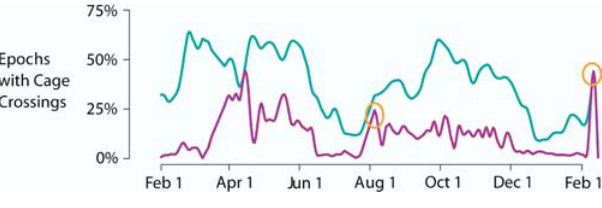
Figure 1. Activity Across the Year The purple line traces the (smoothed) percentage of 30-s epochs at night during which a bird (no. 38) broke an infrared beam by crossing the cage. The blue line shows the same information for the hours of light. Note the broad peak in activity between March and June and the broader and lower peak in activity between August and December, corresponding to the spring and fall migrations, respec- tively. The low levels of activity during July and December through March correspond to the summer and winter nonmigratory periods. The sharp high peaks (orange ovals) in early August of 2003 and early February of 2004 mark brief periods of experimenter-induced